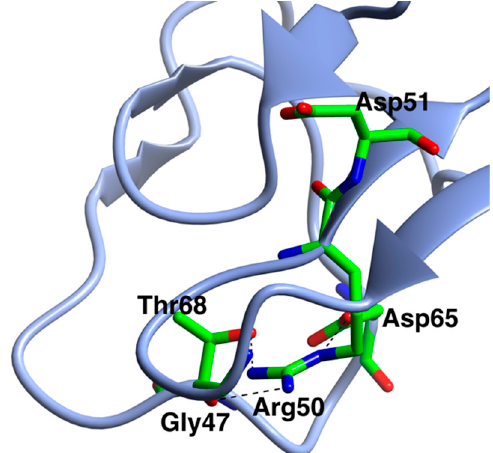
Figure 8. The position of Arg50 adjacent to the catalytic Asp51 in the sequence, showing the residues with which its side chain forms H-bonds, shown as dashed lines.